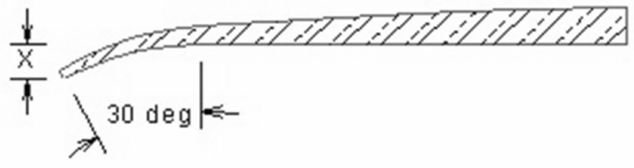
Figure 1. Section of propeller with a cup